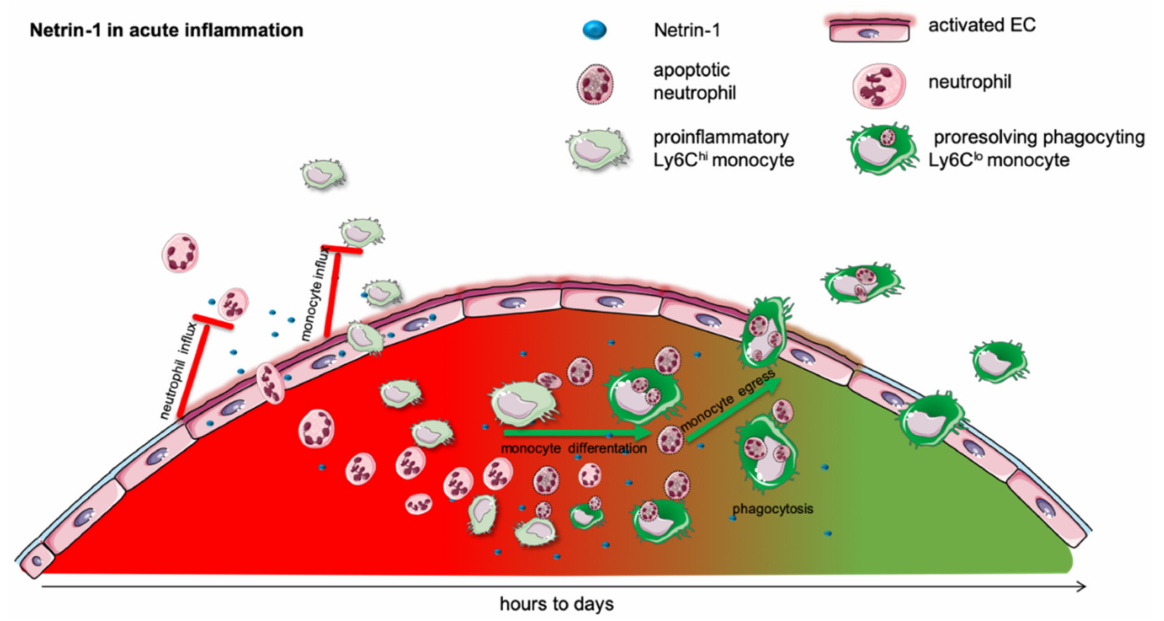
Figure 1. Netrin-1 in acute inflammation. Acute inflammation is defined by a rapid influx of neutrophils into the inflamed tissue to combat the intruding pathogen. This is followed by a monocyte recruitment to extend the rapid immune response. In many different models, it has been shown that netrin-1 can very effectively mitigate the influx of neutrophils and monocytes and thereby dampen the acute inflammatory response. The acute, initial phase is followed by a resolving phase, in which neutrophils undergo apoptosis and are taken up by monocytes. The efferocytosis in turn promotes the differentiation of pro-inflammatory into anti-inflammatory monocytes. This phenotype switch and the monocyte egress in acute inflammation is facilitated by netrin-1. Table 1. Murine studies on netrin-1 and its receptors in acute